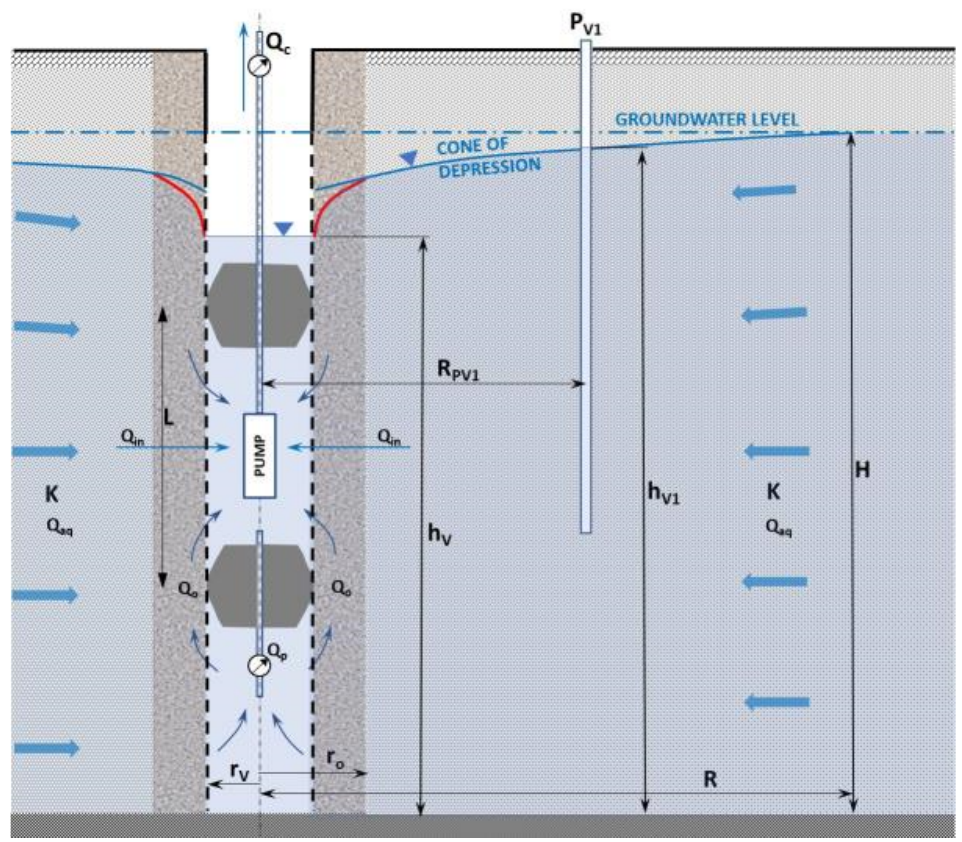
Figure 2. Scheme for determining the amount of groundwater inflow into the extraction well through height L.